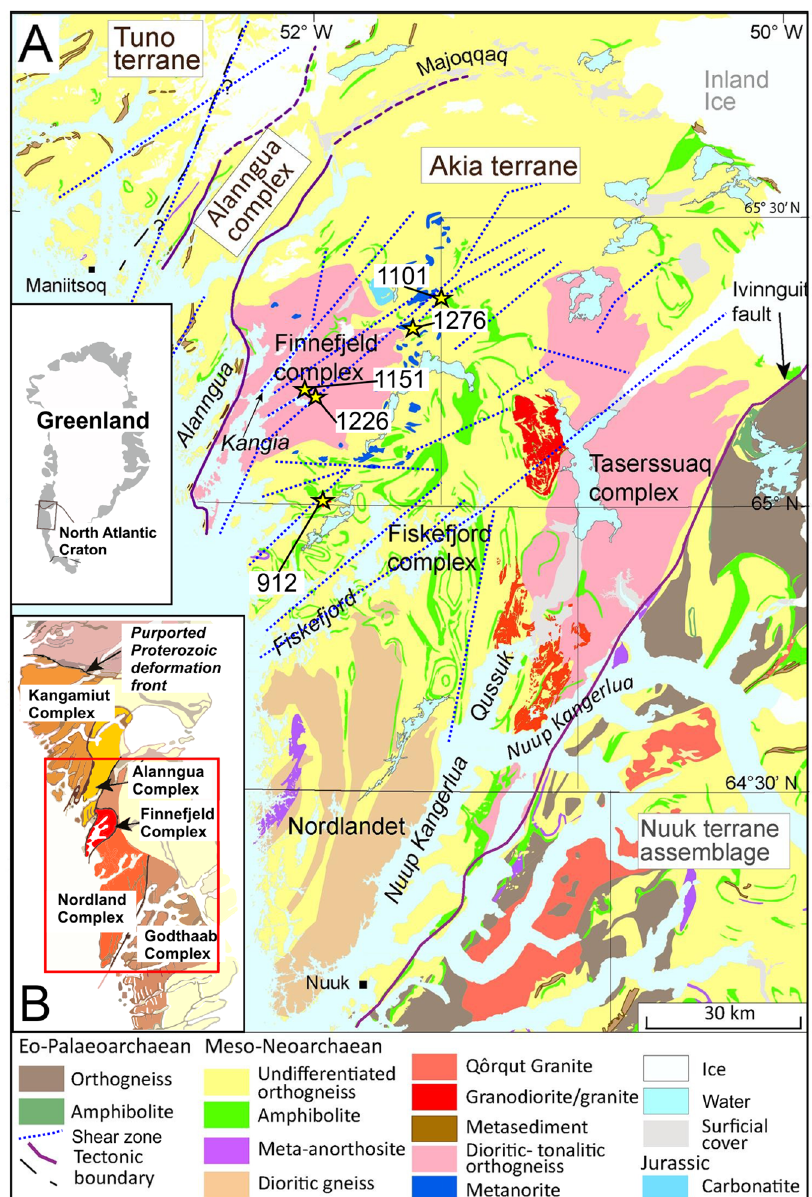
Fig. 1 Schematic geological map of South West Greenland and geographic context of the study region. A Lithological units within the Nuuk-Maniitsoq region 14,69 . Blue dashed lines are major faults inferred from aerial photography. Yellow star symbol denotes sample locations. B Major lithotectonic units/ terranes in the